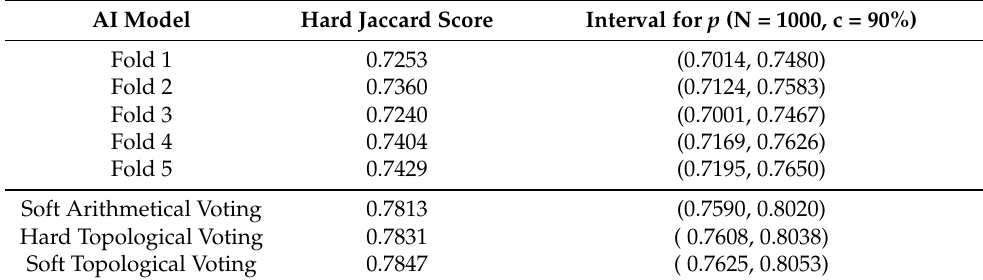
Table 1. Comparison of voting methods on 5 folds for the Salt dataset.